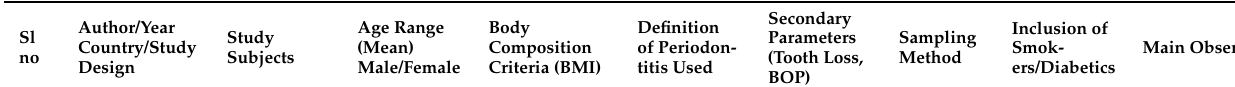
Table 1. Human observational studies included in the systematic